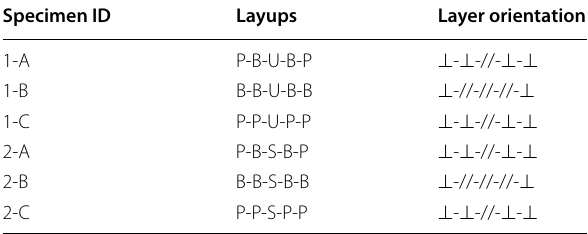
Table 1 Layups of overlaid laminated bamboo lumber